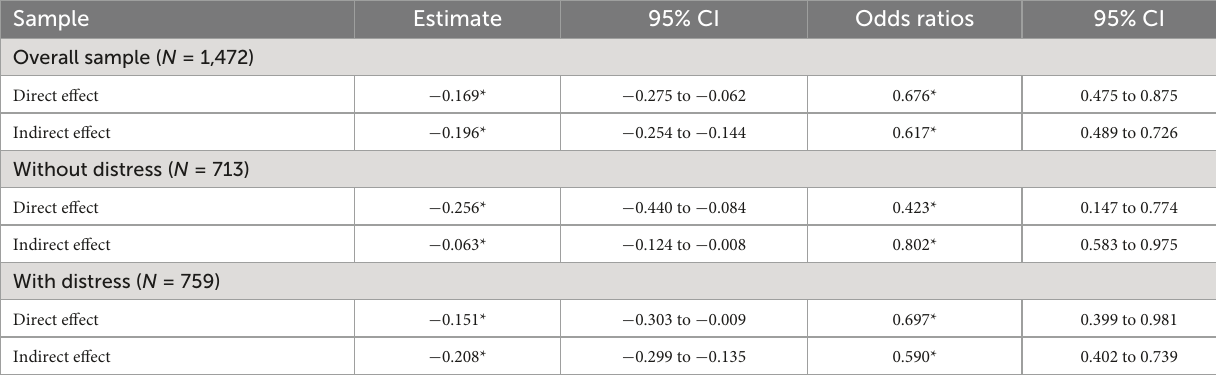
TABLE 4 Direct and indirect effects and associated odds ratios from meaning in life to suicidal ideation via PHQ-4 in the overall structural equation model and across distress groups.